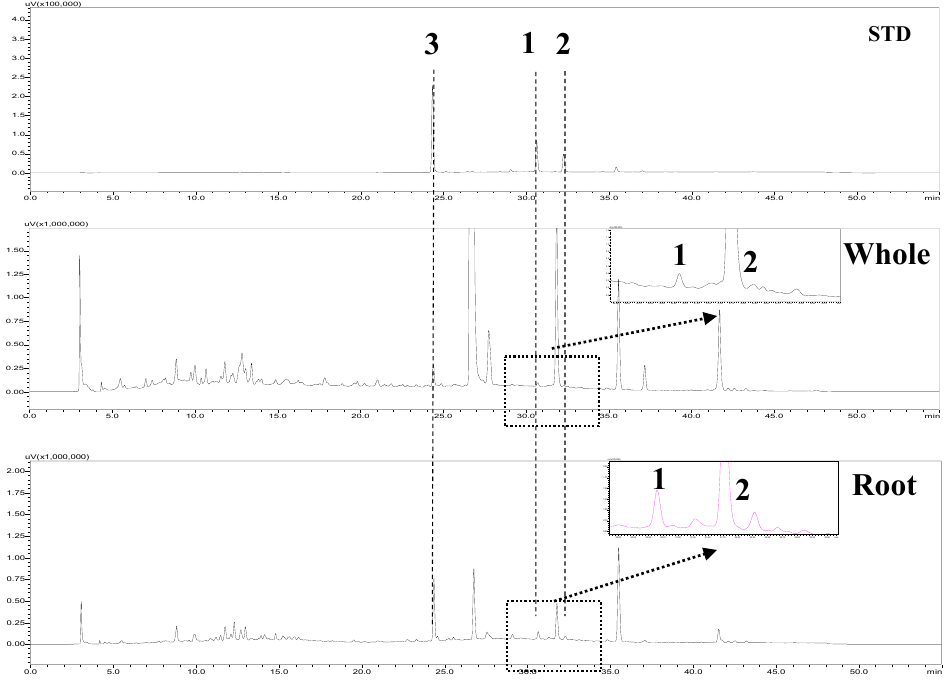
Figure 4. Pattern analysis of selaginellin A ( 1 ), selaginellin B ( 2 ), and selaginellin ( 3 ) in methanol extracts (0.5 mg/mL) from the S. tamariscina whole plants and roots. Table 3. Content of the analyzed selaginellins ( 1 – 3 ) in methanol extracts from each part of S. tamariscina.